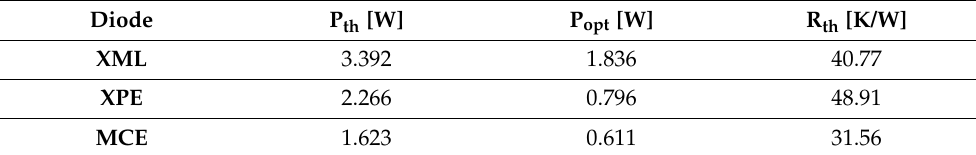
Table 4. Thermal power, optical power, and thermal resistance of the tested power LEDs operating without any